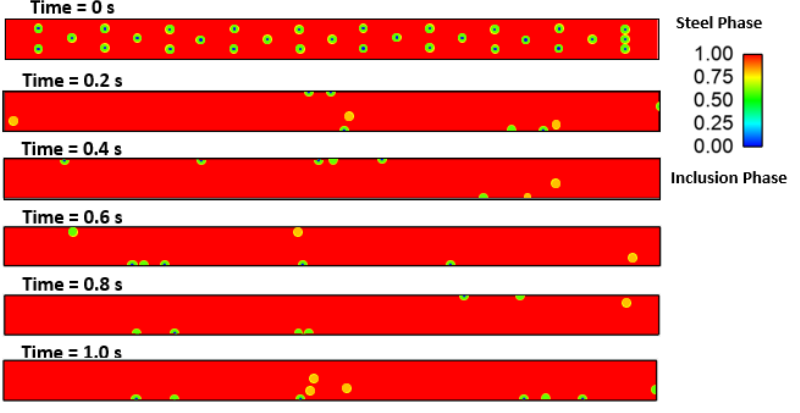
Figure 7. 4.29: Motion of alumina inclusion during solidification (initial temp: 1893 K, sulfur: 40 PPM).